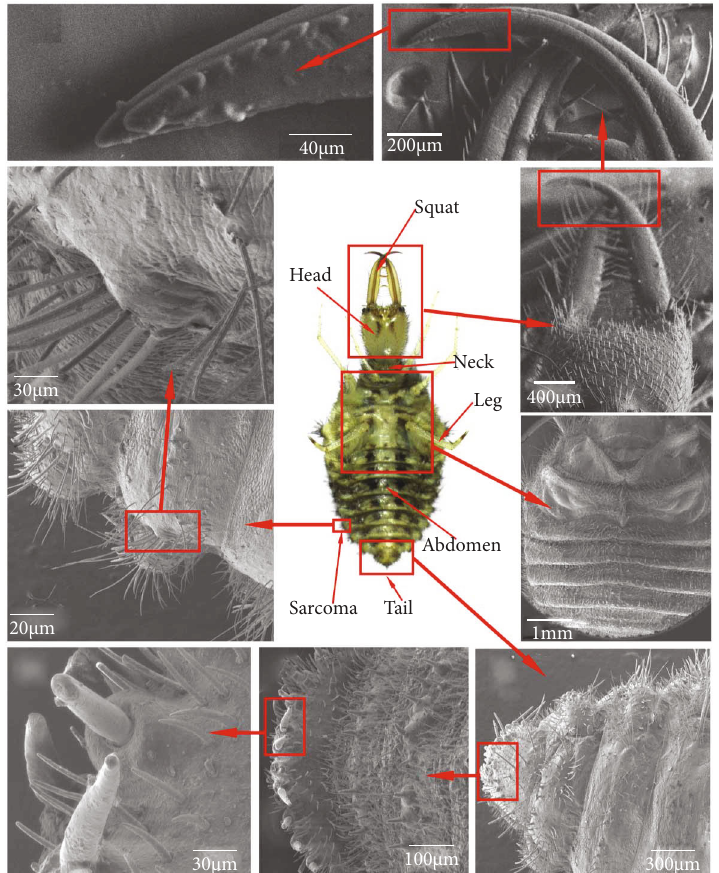
Figure 1: Antlions surface structure of the whole body. (a) The whole body. (b) Tip of jaw. (c) Jaw. (d) Magni fi ed view of margin. (e) Marginal structure. (f) Head. (g) Back. (h) Tail setae. (i) Magni fi ed view of tail. (j)